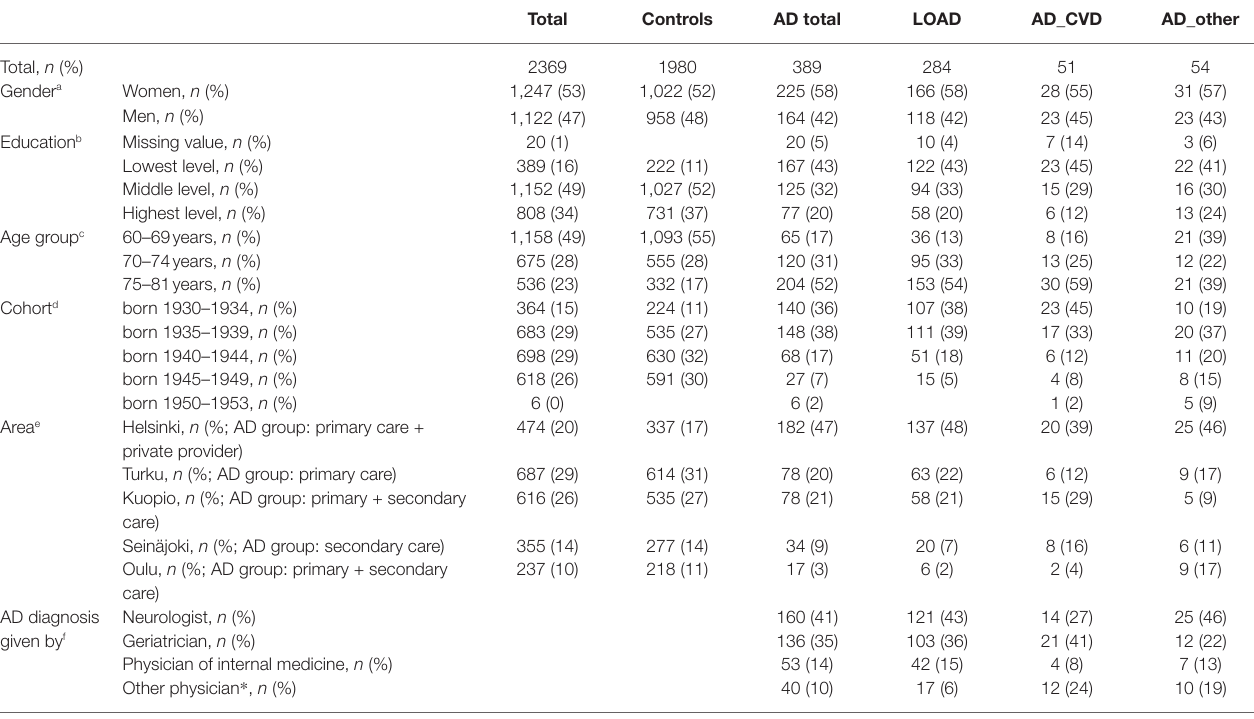
TABLE 1 | Study population included in cognitive performance